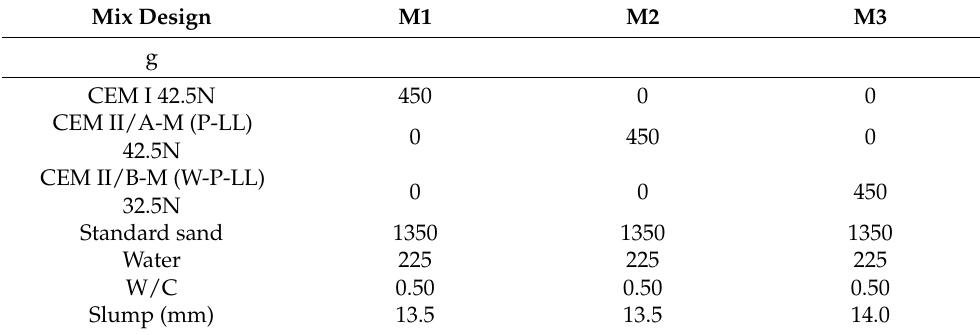
Table 3. Mix design and characteristics of mortars.